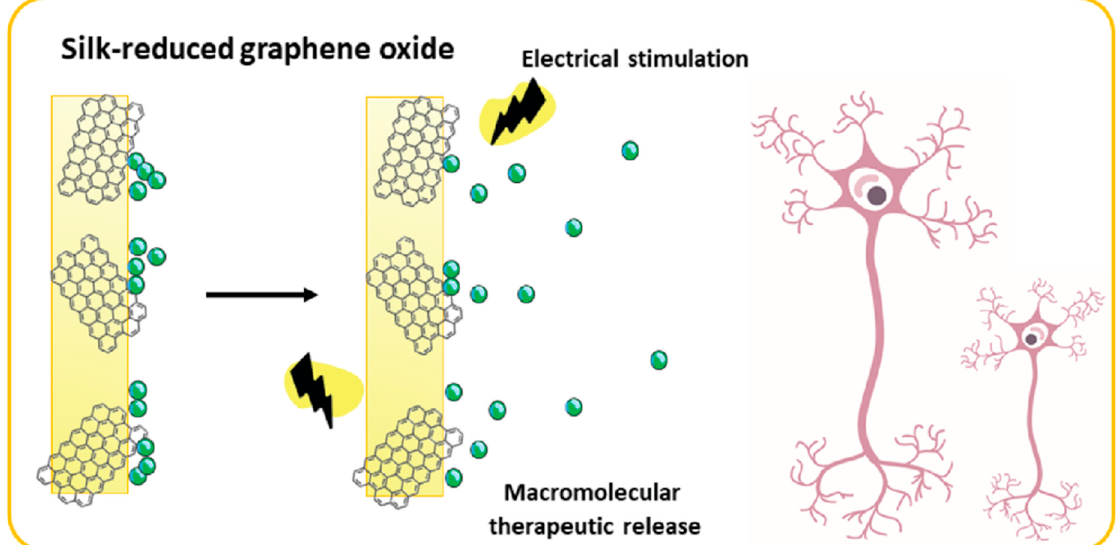
Figure 8. The composite silk fibroin and graphene oxide films have electroconductive properties and allow for loading and the controlled release of nerve growth factor- β upon the application of an electrical stimulus. Reproduced from Magaz et al. [121], Open Access.